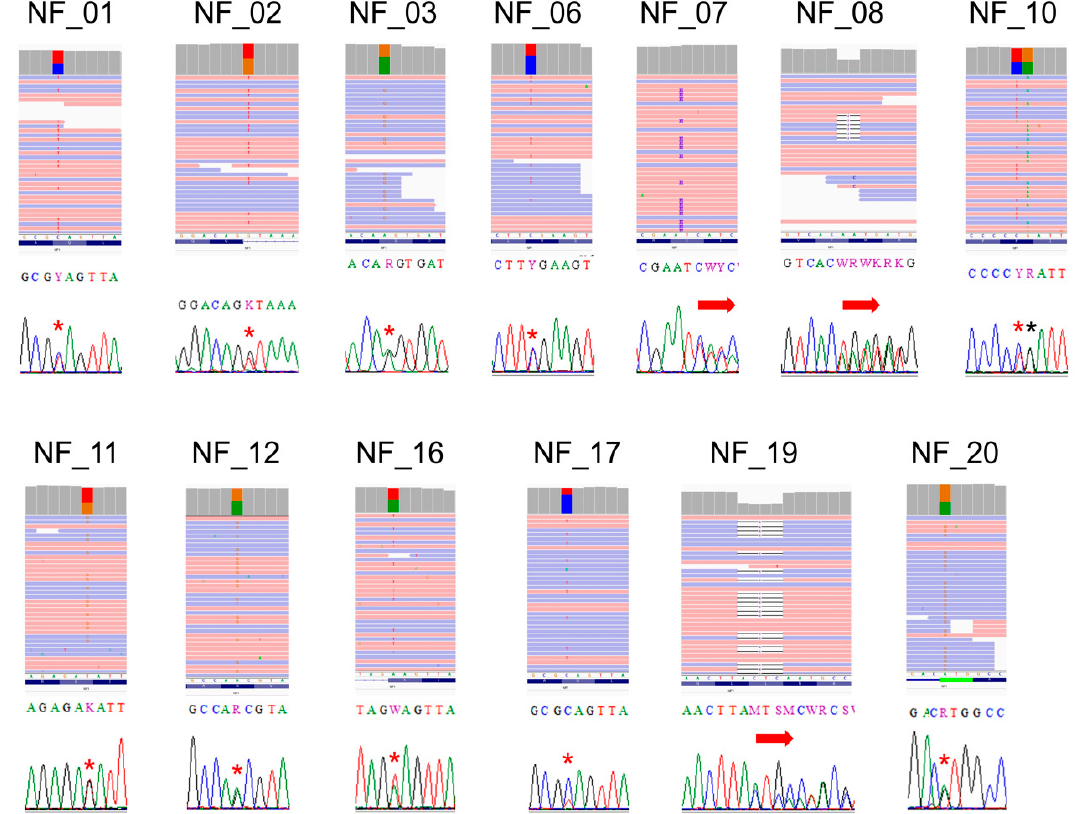
Figure 2. NGS (IGV) and Sanger validation of the detected NF1 mutations. Single-base substitutions are indicated by stars, and frameshifts are indicated by arrows. Note, in NF_10, NGS, but not Sanger sequencing, shows the mutation, and SNP are located on a different allele. In NF_17, both NGS and Sanger show an unbalanced mutation allele frequency, indicating a mosaic mutation.